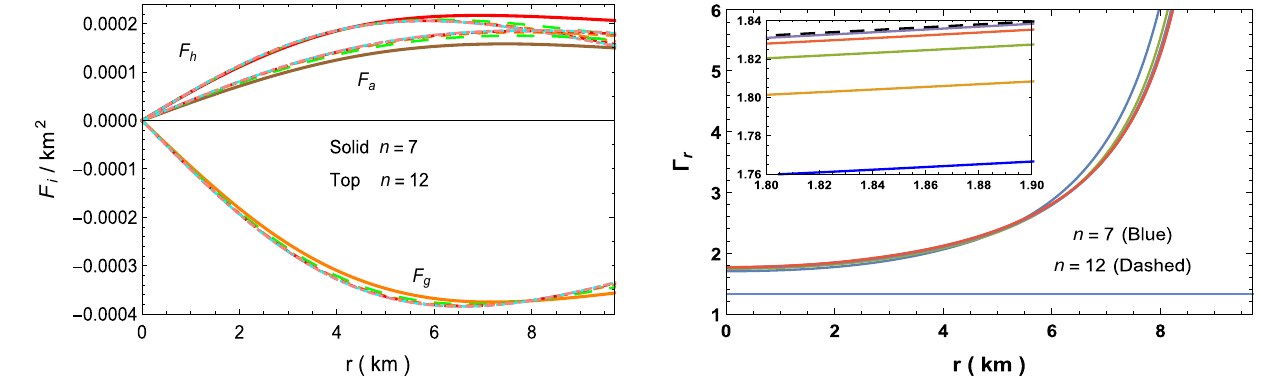
Fig. 12 Adiabatic index profiles of PSR J1614-2230 for M = 1 . 97 M (cid:6) , R = 9 . 69 km and b = 0 .